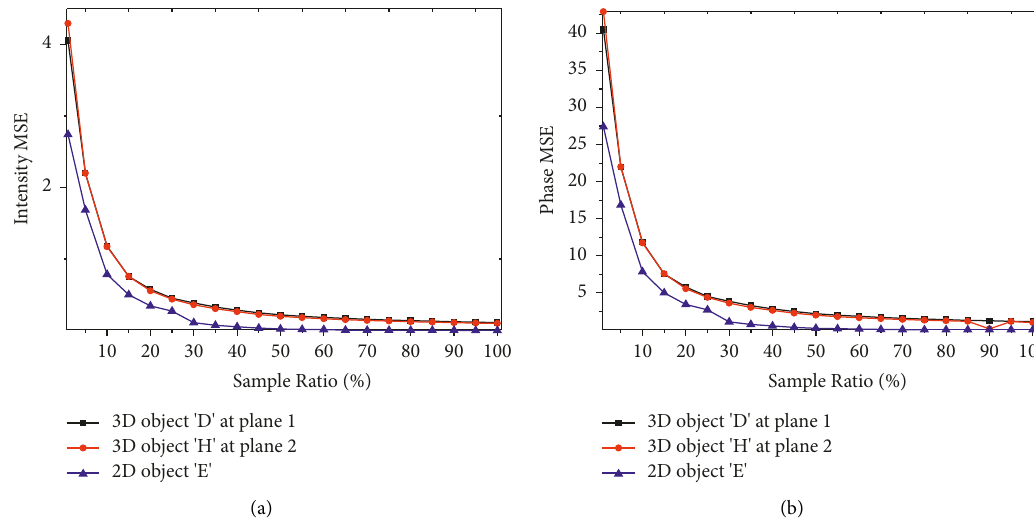
Figure 6: Performance of sample ratio versus MSE between decrypted and original complex wave: (a) MSE of intensity deviation; (b) MSE of phase